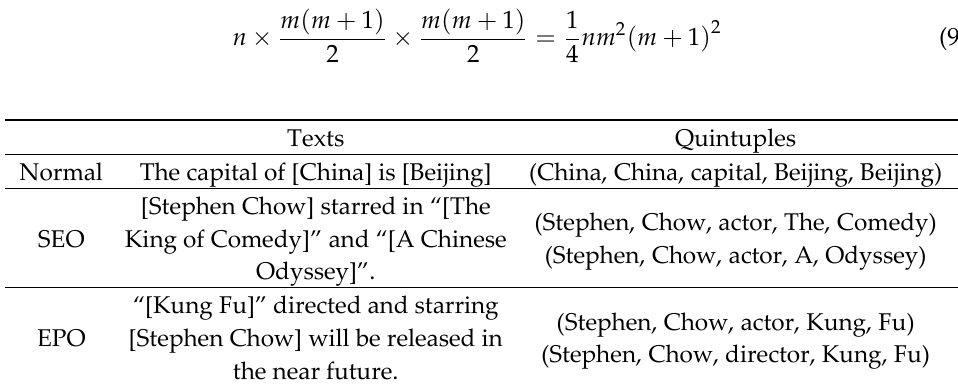
Figure 4. Examples of overlapping quintuples are divided into normal, single entity overlap (SEO), and entity pair overlap (EPO).